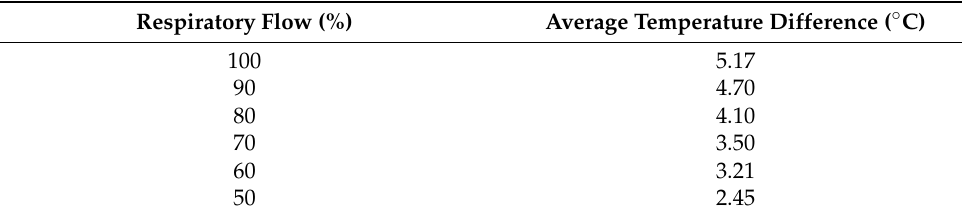
Table 2. Average temperature difference of the hot junction under different respiratory